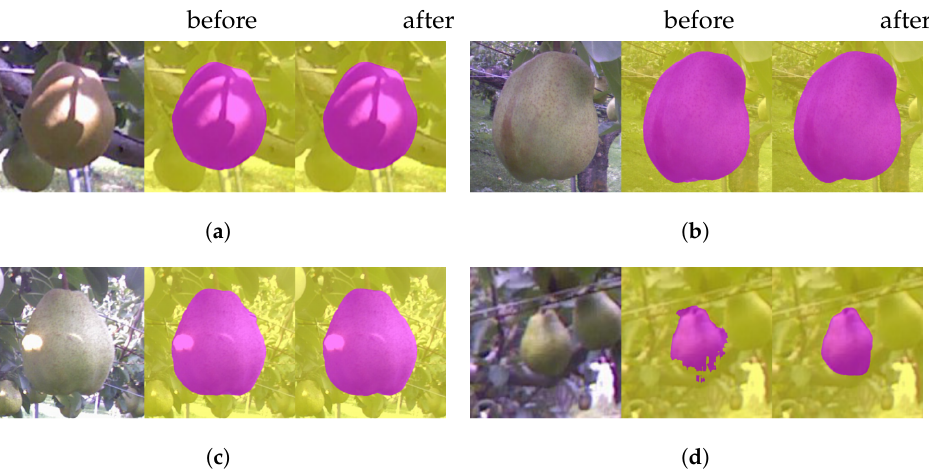
Figure 10. Before and after the fine-tuning. ( a ) This image was properly processed even before the fine-tuning. ( b ) The bottom contour line became more precise. ( c ) The right boundary became more accurate. ( d ) A good amount of